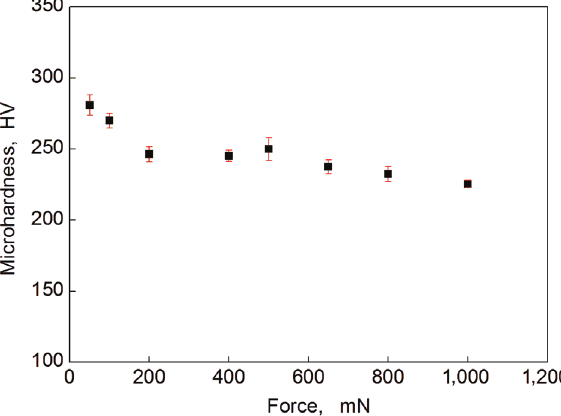
Figure 8: The influence of the load of the indenter tip on the microhardness of the superalloy Inconel 625.